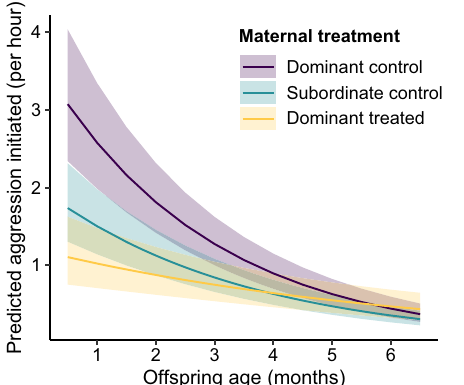
Fig. 2 Different model-predicted rates of offspring aggression by age, based on maternal status and treatment condition. The initiation of aggression by meerkat offspring is signi fi cantly predicted by their age during the fi rst 6 months of life ( P < 0.001) and by their mother ’ s status and treatment condition during pregnancy ( P = 0.001): dominant control (purple), subordinate control (teal), and dominant treated (orange). Solid lines represent model-predicted rates (frequency/hour), with 95% con fi dence intervals. Analyses used GLMMs, with two-tailed χ 2 , based on 103 offspring, observed during 5661 focal sessions. See Supplementary Fig. 3 for the distribution of raw data.